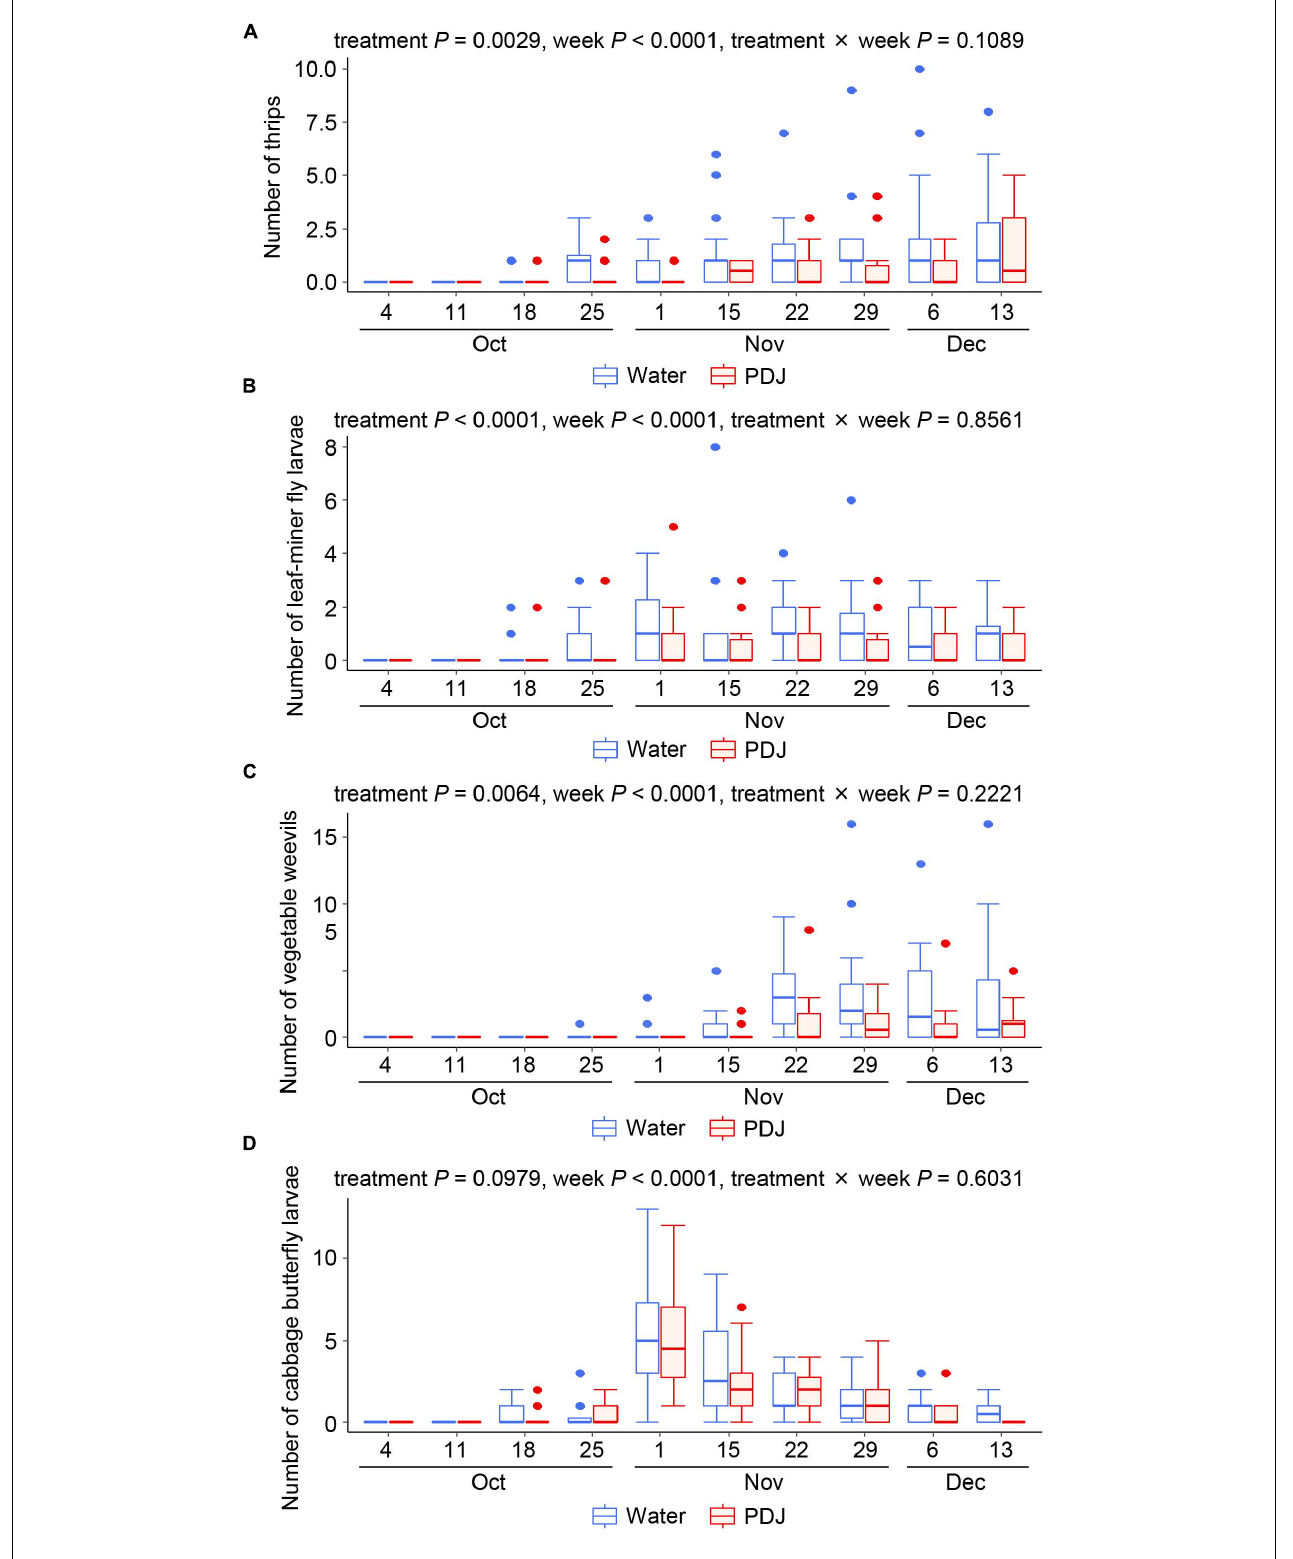
FIGURE 2 | Occurrences of thrips (A) , leaf-mining fly larvae (B) , vegetable weevils (C) , and cabbage butterfly larvae (D) on Japanese radish plants in the field during the observation period (GLMM).